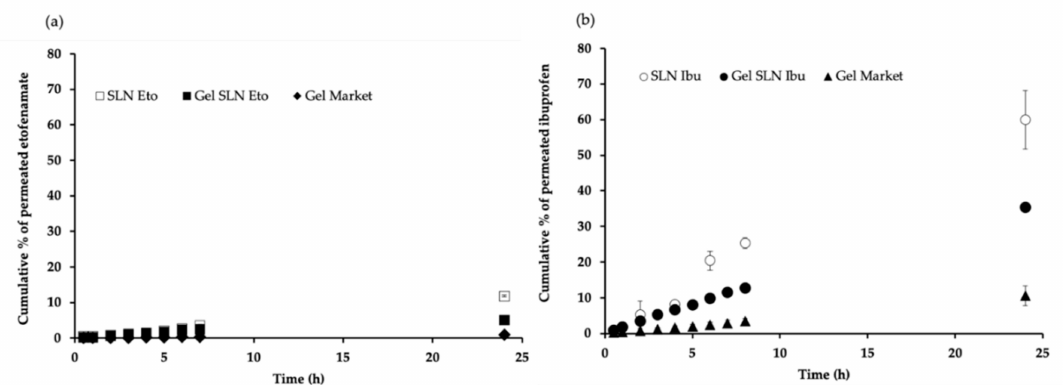
Figure 10. Permeation profiles of ( a ) etofenamate-SLN (SLN Eto), etofenamate-SLN hydrogel (Gel SLN Eto), and etofenamate reference gel (Gel Market-Reumon ® Gel 5%) and ( b ) ibuprofen-SLN (SLN Ibu), ibuprofen-SLN hydrogel (Gel SLN Ibu), and ibuprofen reference gel (Gel Market-Ozonol ® 5%) through human skin cells (SC). Results are expressed as mean ± S.D.; n =